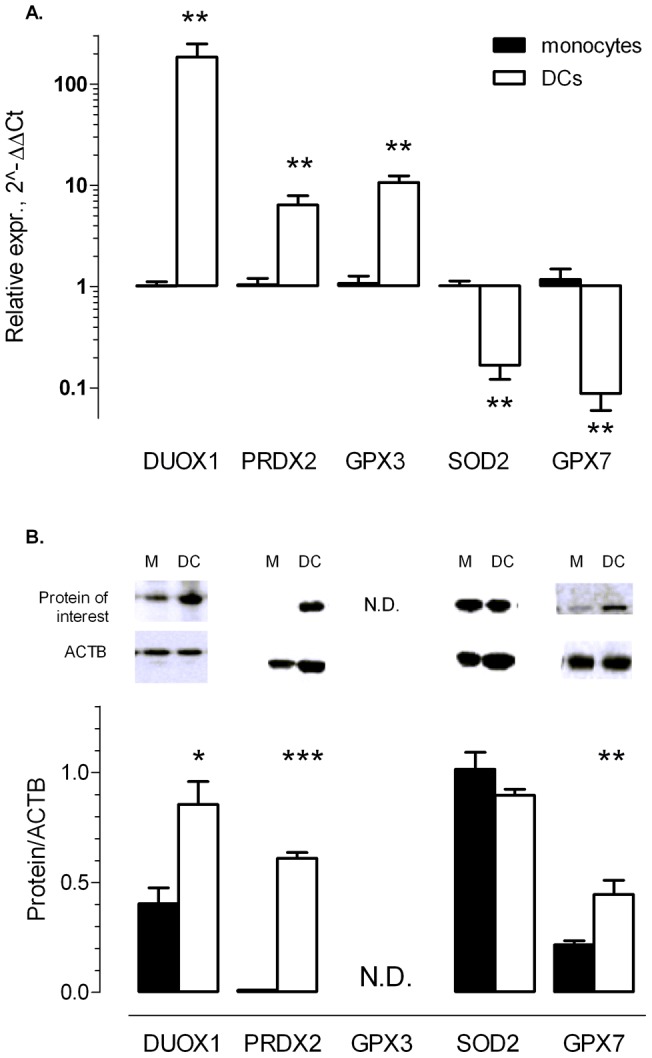
mRNA and protein expression of pro-and antioxidants in moDCs and monocytes. A.
Relative mRNA expression of DUOX1, PRDX2, GPX3, SOD2 and GPX7 in monocytes and moDCs. mRNA expression was analyzed using Taqman assays in individual non-pooled RNA extracts. Data were normalized to expression of ACTB and monocytes served as control group (expression set to 1). B.
Western blot analysis of DUOX1, PRDX2, SOD2 and GPX7 during differentiation from monocytes (M) to moDCs (DC). The antibody against GPX3 did not yield signals that were distinguishable from background noise in the immunoblots. Representative blots (top panels) and mean densitometric ratios of protein of interest/ACTB. Values show mean ± SEM, n = 4. N.D.  =  not detectable. *P<0.05, **P<0.01, ***P<0.001.